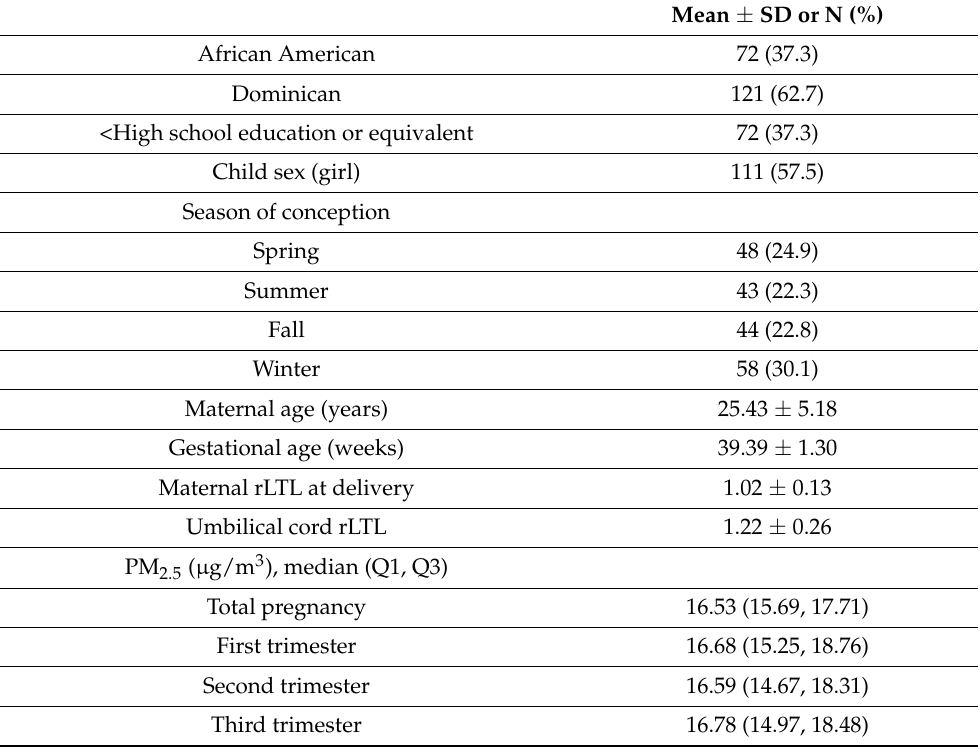
Table 1. Characteristics and cord and maternal relative leukocyte telomere length (rLTL) in the CCCEH Mothers and Newborns birth cohort (n =